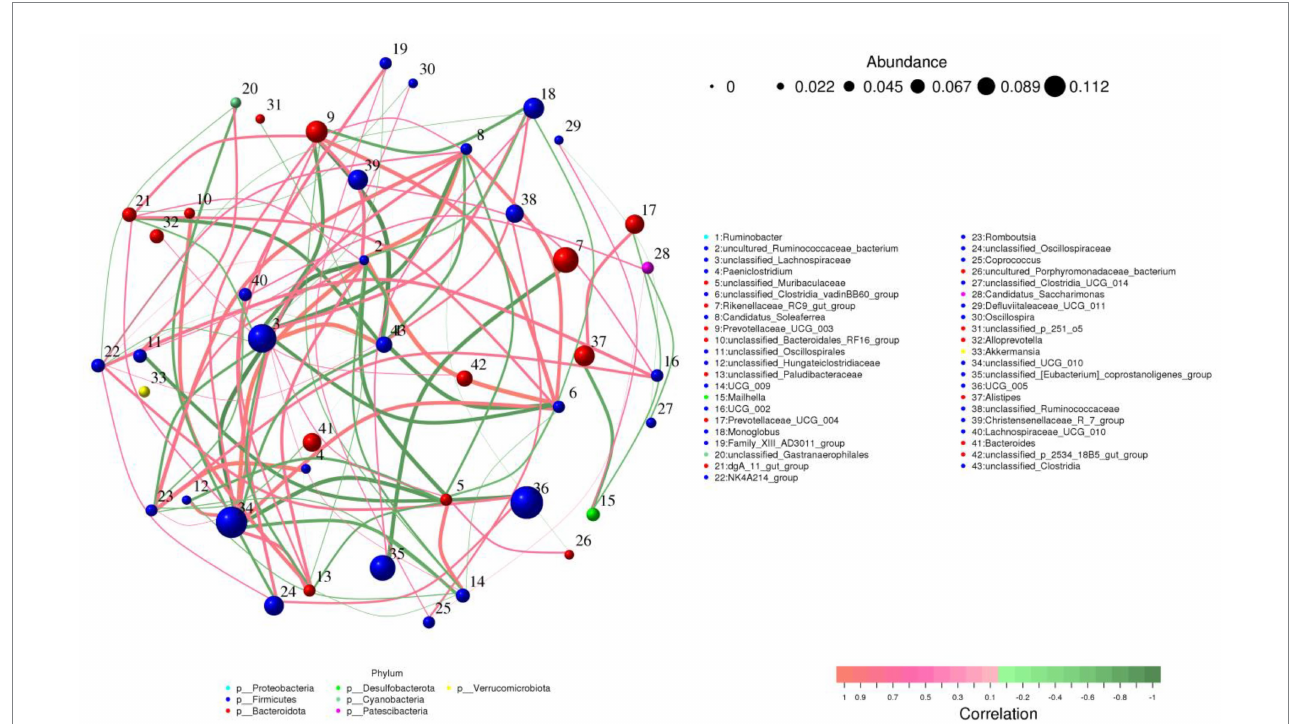
FIGURE 7 Correlation network analysis of gut microbiota. Positive and negative correlations are indicated by red and green lines,